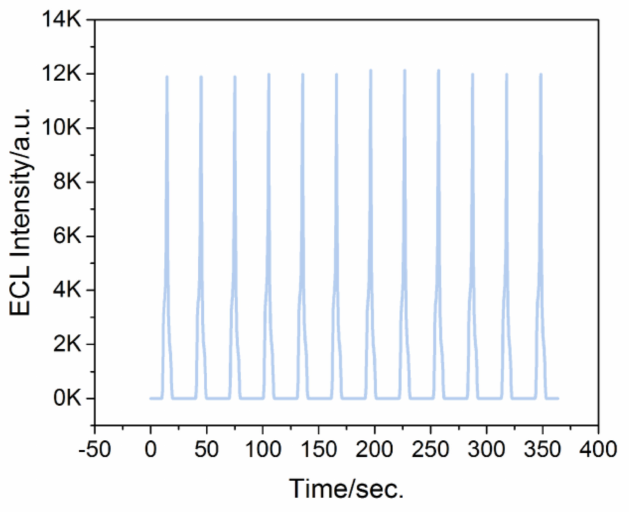
Figure 7. ECL–time curve profile. The detection was performed at pH 8.5 (0.1 M PBS) in the presence of 0.5 mM Ru(bpy) 32+ with 1.0 mM AZA; PMT = 900